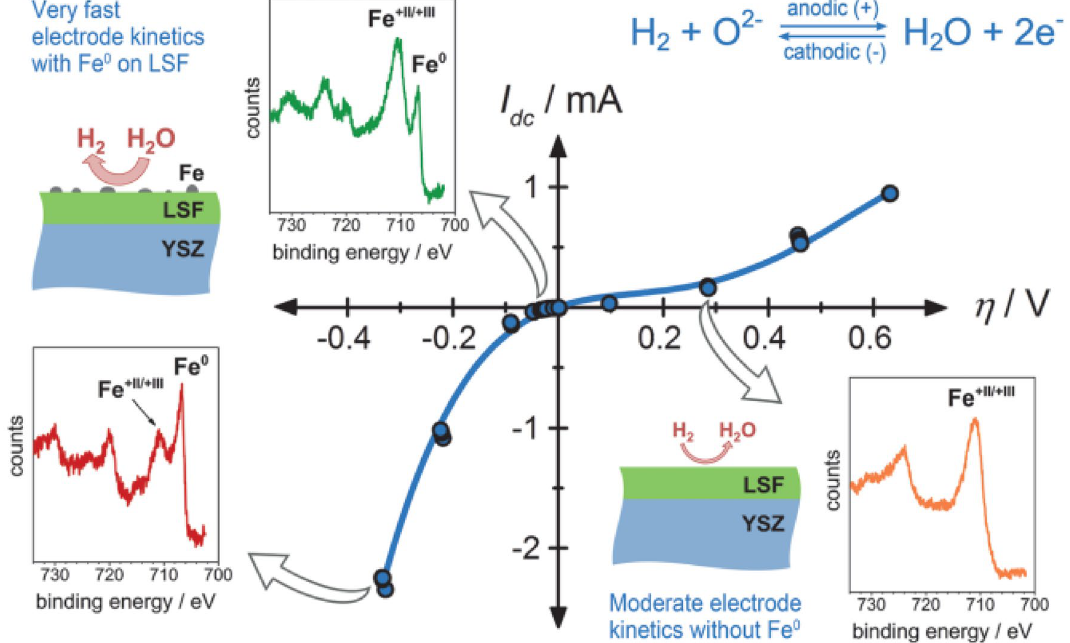
η Fig. 8 Current-overpotential curve ( I trode is given top right. For selected points of the curve (indicated by ) of LSF in a humid dc vs. arrows), Fe 2p XPS spectra are shown as insets. The sketches indicate reducing atmosphere (0.25 mbar H 2 + 0.25 mbar H 2 O). The symbols the situation for the LSF surface and the resulting reactivity, respec- represent measured values; the line is not a fit but a guide for the eye. tively. Reproduced with permission [58]. Copyright 2015, The reaction proceeding on the surface of the LSF working elec-